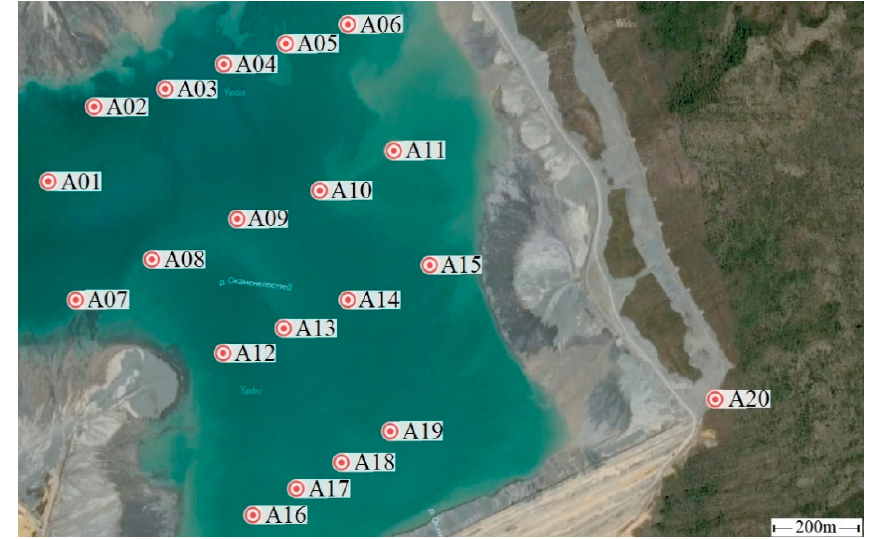
Figure 3. Schematic of water sampling locations within the settling pond.